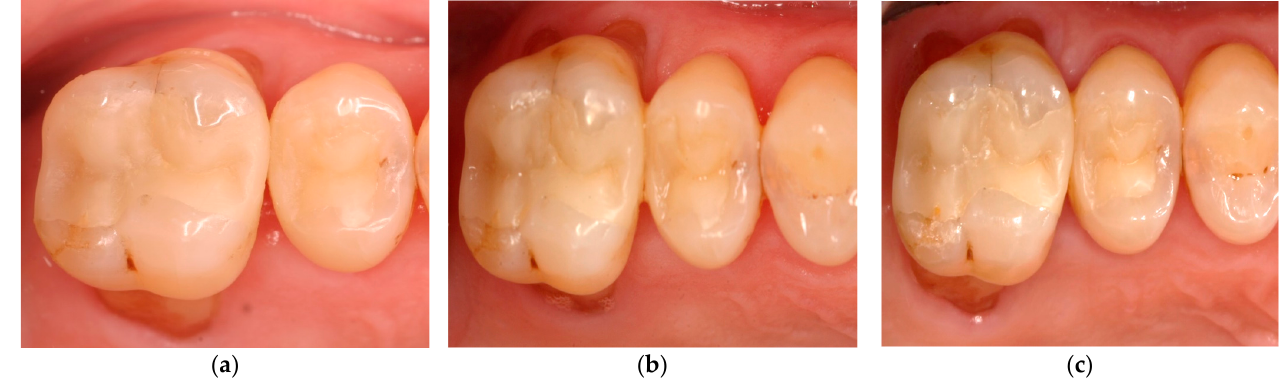
Figure 6. Clinical situation of Pat. No. 18: filling 15 od without flowable composite: control group, all criteria Code Alpha; filling 16 mod with flowable composite as intermediate liner: test group: margin adaption was evaluated as Code Beta all other criteria were rated Code Alpha: ( a ) baseline; ( b ) after 12 months; and ( c ) after 24 months.